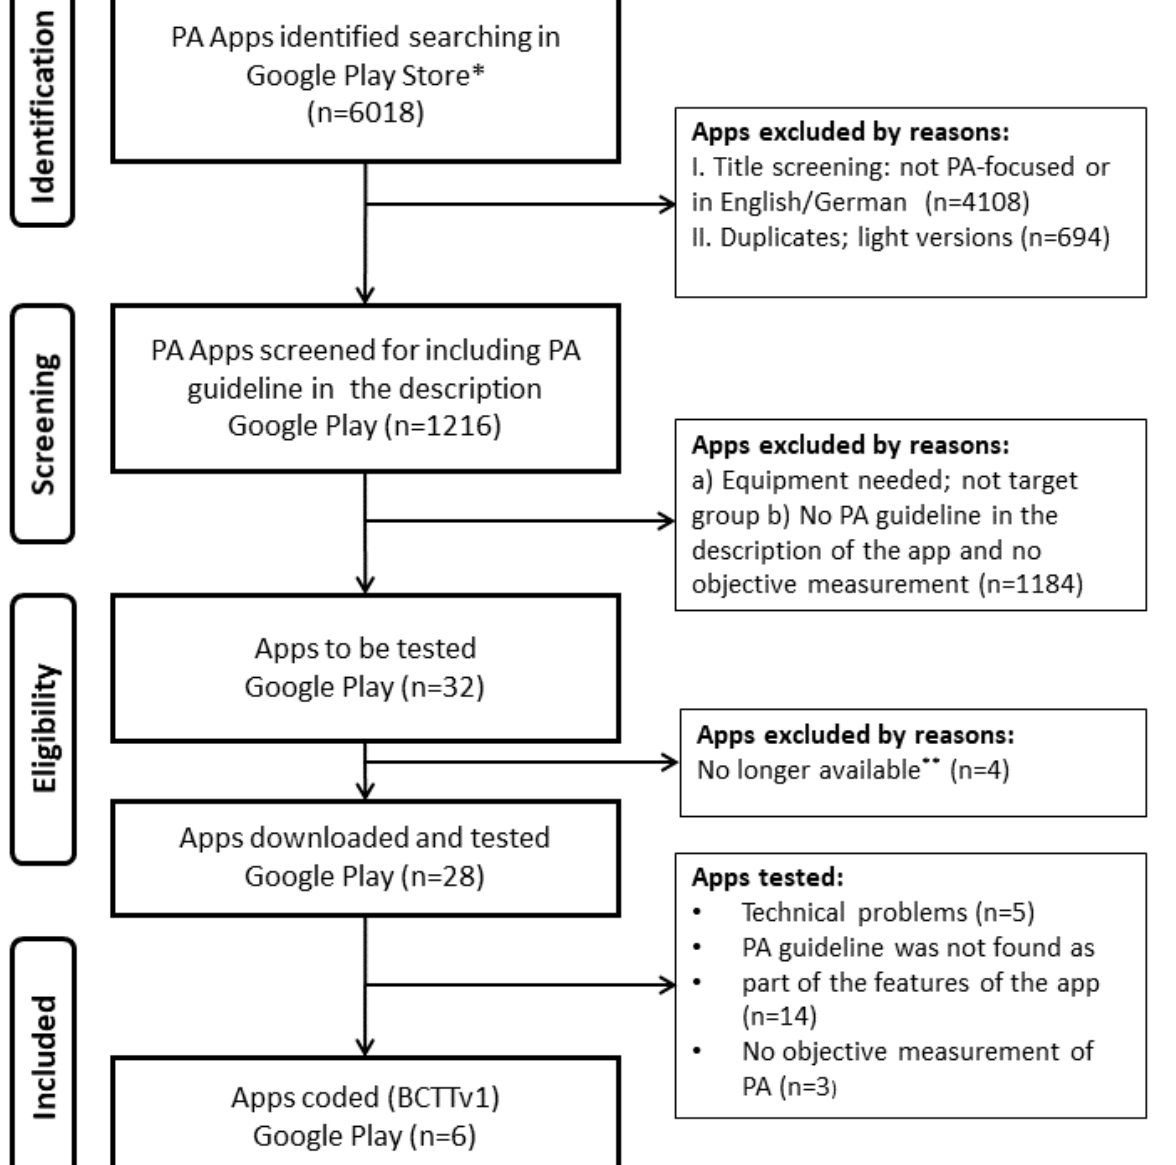
Figure 1. Overview of steps for selecting physical activity (PA) and fitness apps. BCTTv1: Behavioral Change Technique Taxonomy